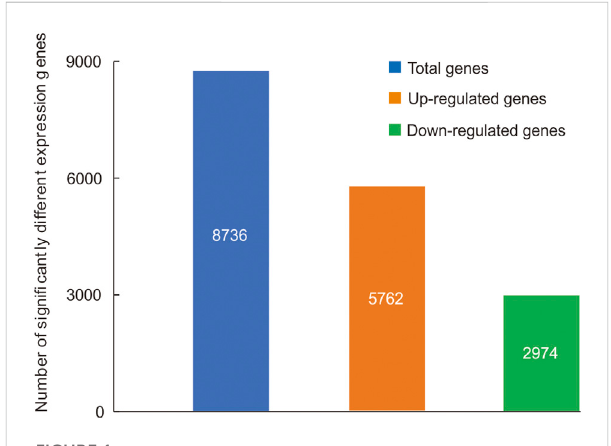
FIGURE 1 Signi fi cantly differentially expressed genes (sDEGs) between the head and thorax transcriptomes of Gynaephora aureata